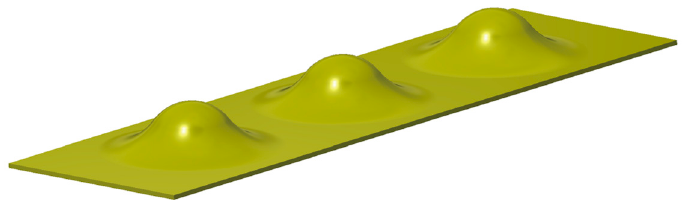
Figure 2. Shape of pod structure.